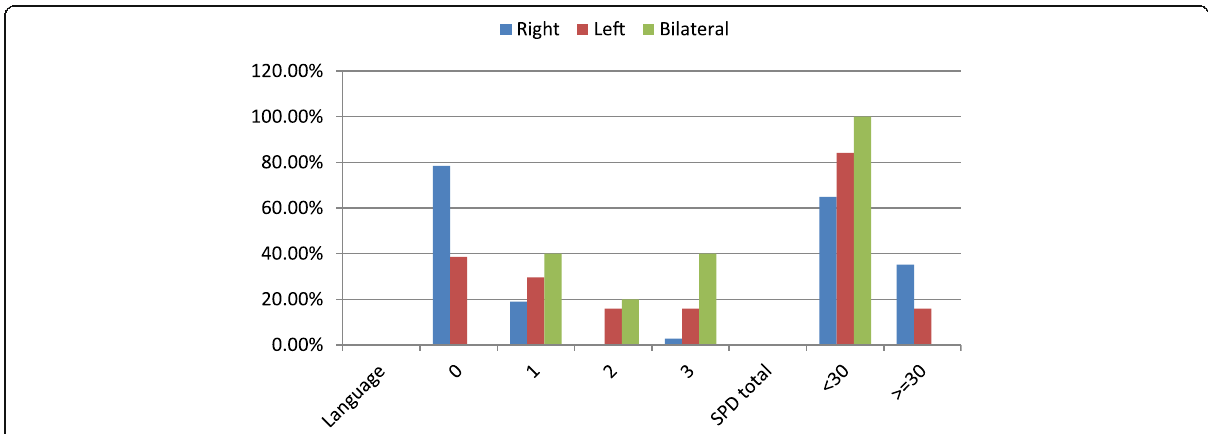
Fig. 6 Language deficit distribution among right, left, and bilateral hemispheric strokes according to NIHSS language subscale and total SPD